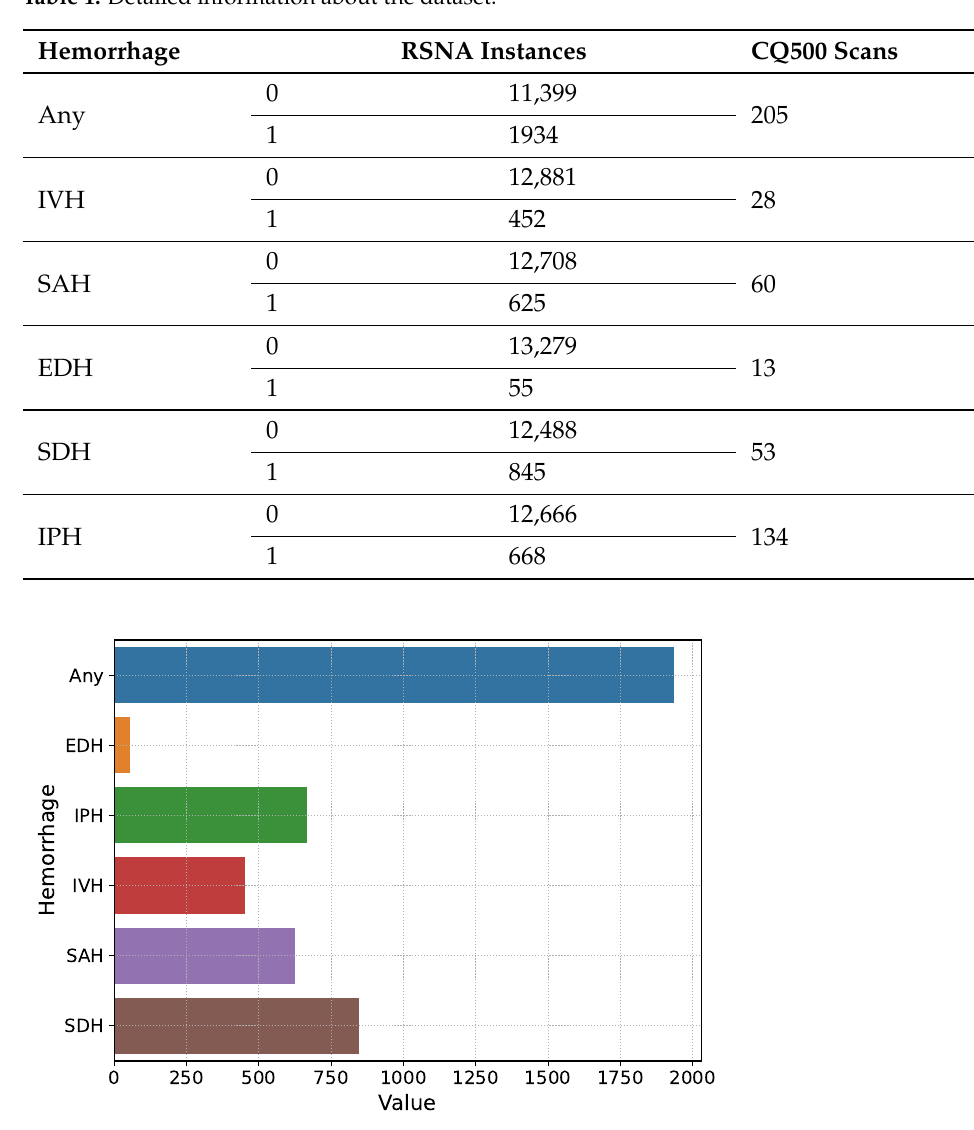
Table 1. Detailed information about the dataset.